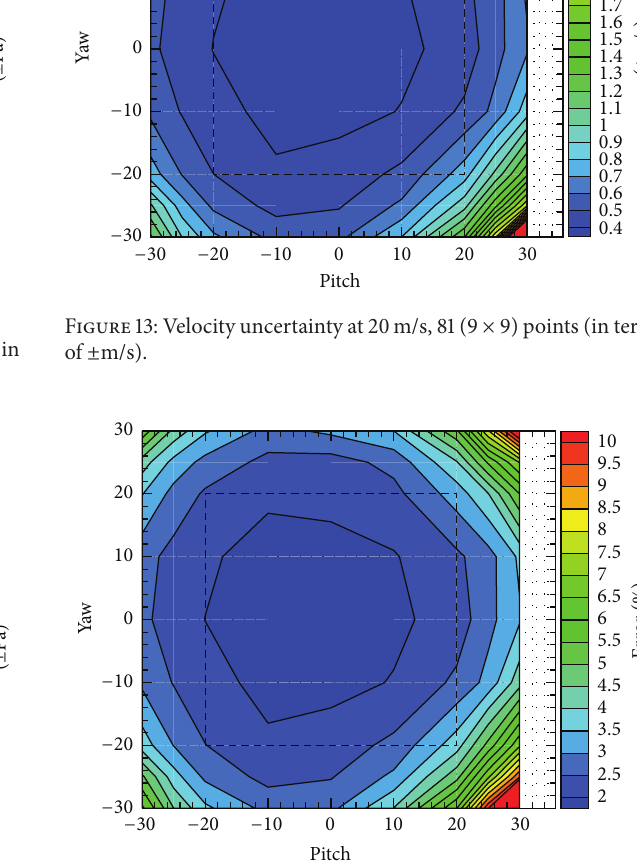
Figure 14: Velocity percent error at 20 m/s, 81 (9 × 9) points (in terms of percentage from